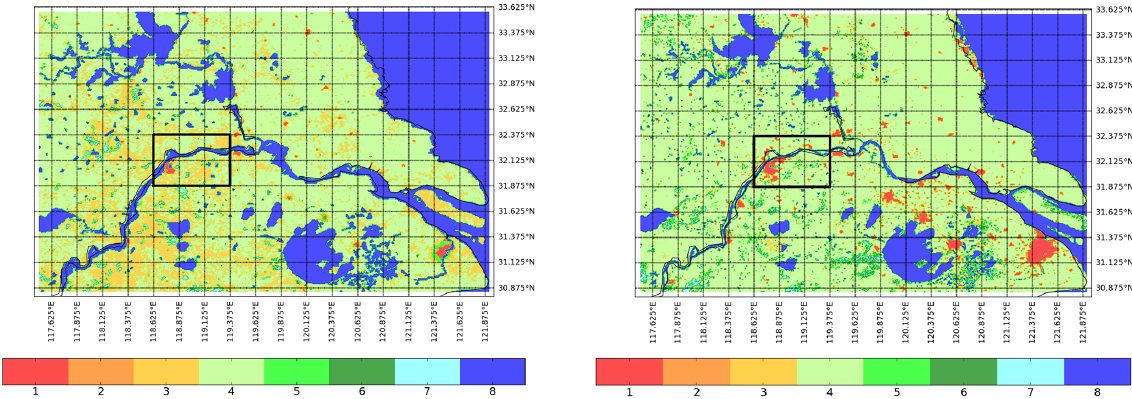
Figure 1. Land use over the Jiangsu Province from Global Land Cover Facility (1994) (left) and the GlobCover Land Cover (2009) (right) and as used in CHIMERE v2006 and CHIMERE v2013. The eight categories are: 1. Urban, 2. Barren land, 3. Grassland, 4. Agricultural land, 5. Shrubs, 6. Needleleaf forest, 7. Broadleaf forest, 8. Water. The solid rectangle (about 50 × 90km 2 ) indicates the 6 grid cells that cover the Nanjing area.